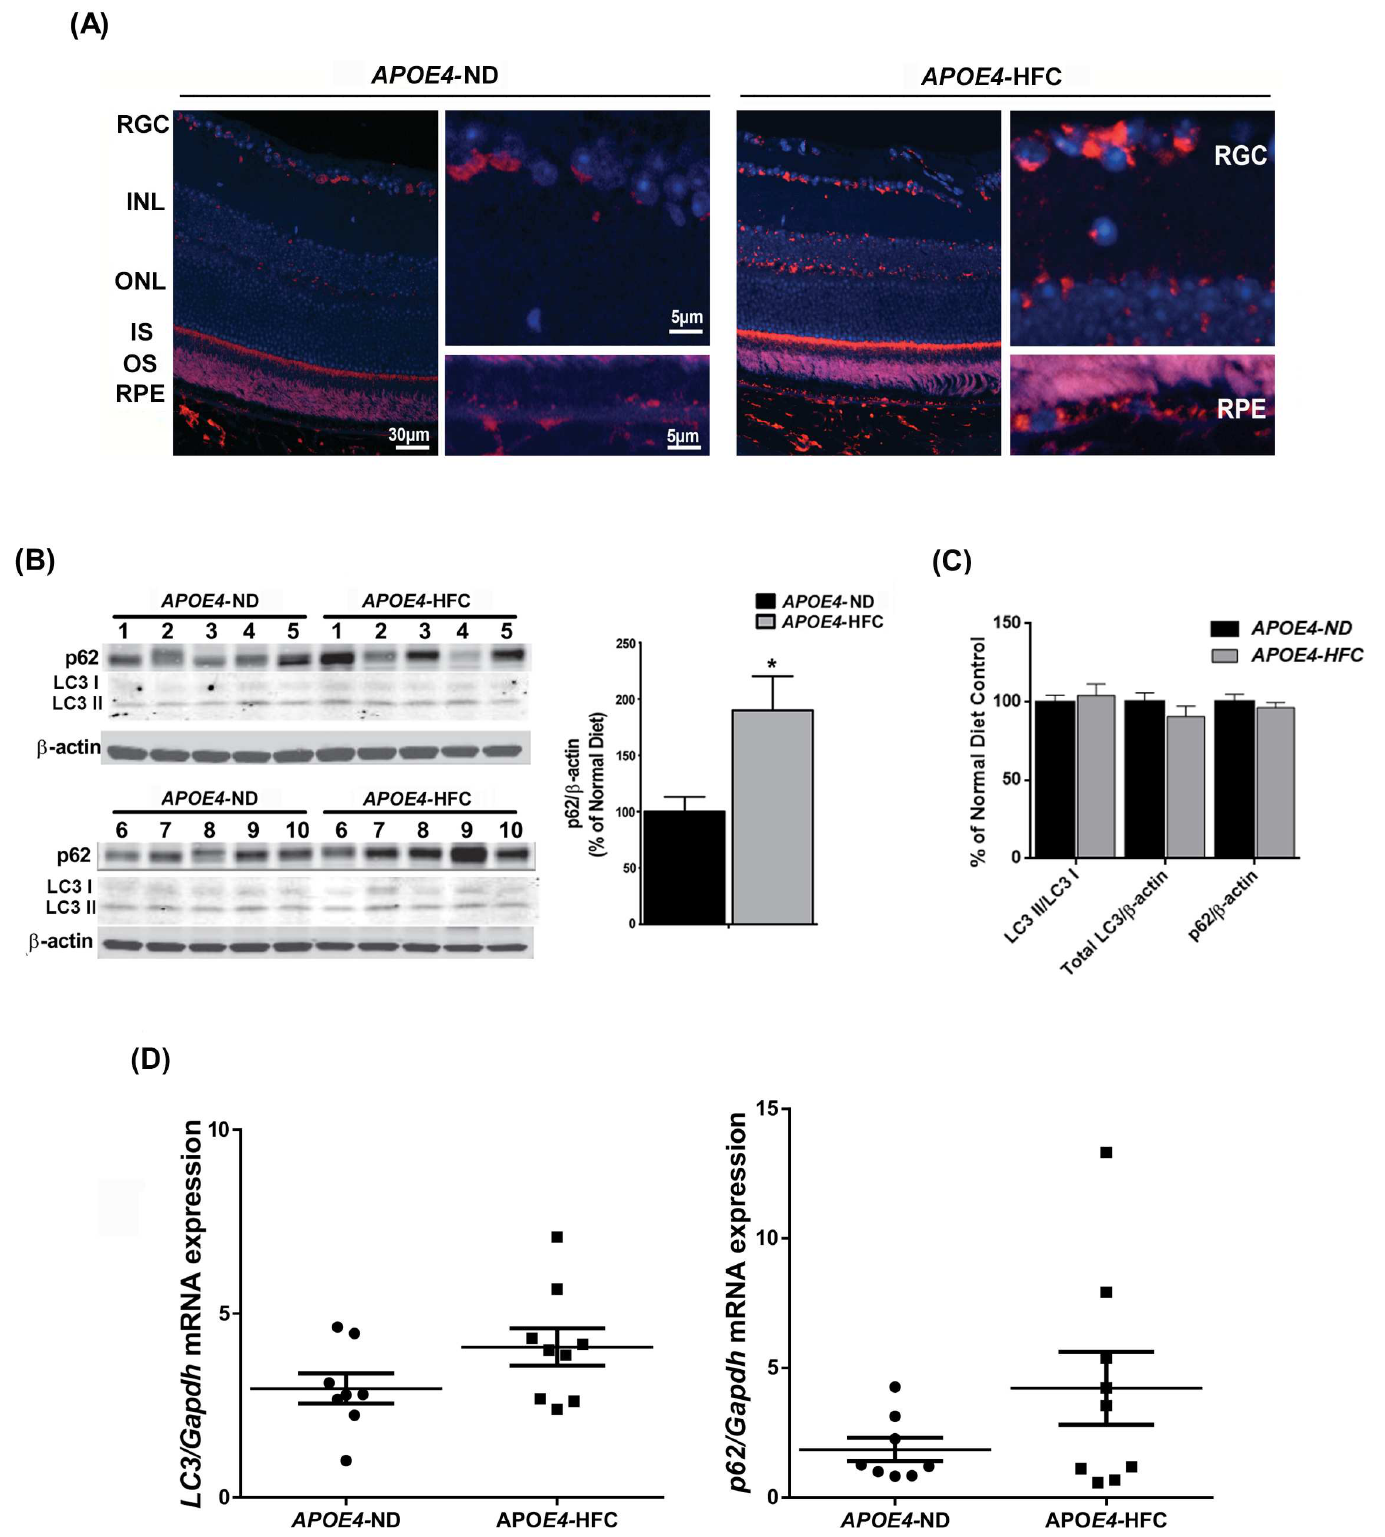
Fig 2. p62 expression is enhanced in AMD mice model. APOE4 mice at the age of 18–20months were fed a high fat, cholesterol enricheddiet (HFC) for 2 months and control age-matched APOE4 mice were kept on a normal diet (ND), ( A) Paraffin embedded mouse retina sectionsfrom each group (n = 6,